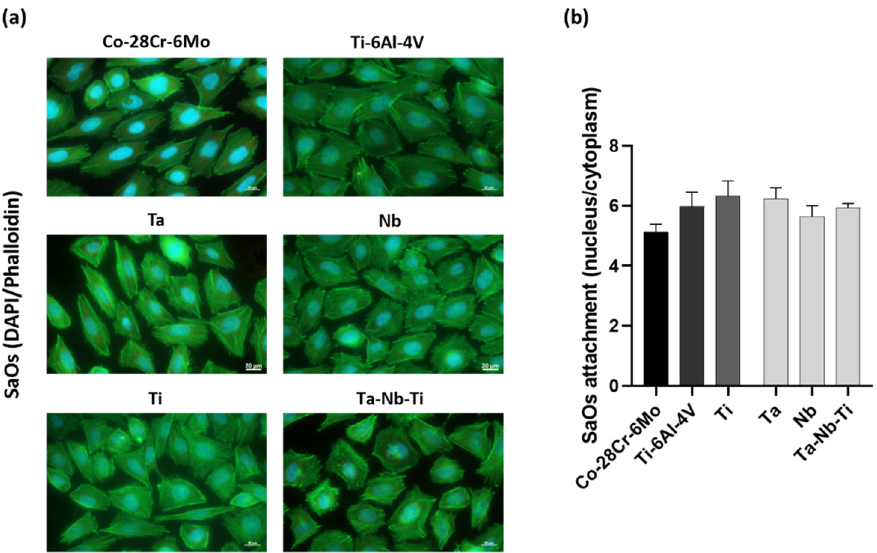
Figure 6. Osteoblast attachment to alloy surfaces. SaOs-2 cells were incubated on samples manufactured from standard implant alloys data from [46] (Co-28Cr-6Mo, Ti-6Al-4V and pure Ti) and compared to elemental Ta and Nb and novel alloy Ta-Nb-Ti. ( a ) Representative pictures of SaOs-2 attachment to the materials after 24 h (cytoskeleton: green, nucleus: blue). ( b ) Calculation of nucleus to cytoplasm ratio for the tested alloys (Mean ± SEM (standard error of mean), N = 3, p = 0.4 using one-way ANOVA (analysis of variance)).